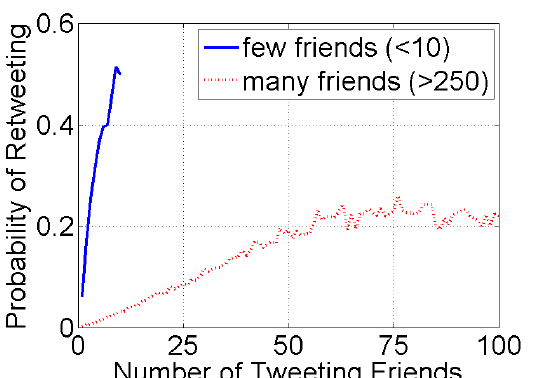
Figure 7. Exposure response function for Twitter. The figure shows the average probability to retweet a message as a function of the number of friends who previously tweeted it for two classes of users, separated according to the number of friends they follow. The well-connected users with many friends are less likely to retweet; hence, they are less susceptible than users with few